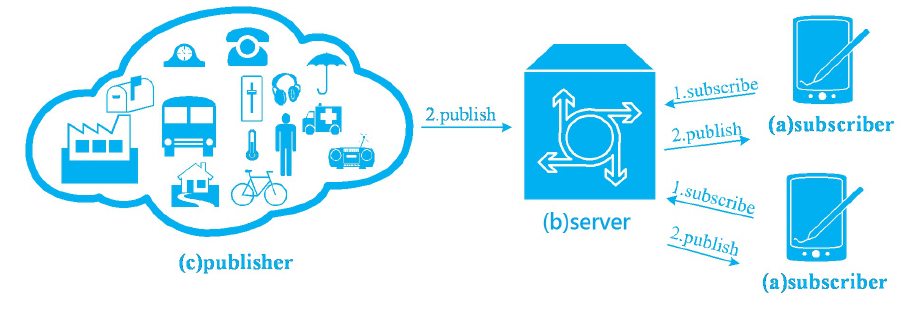
Figure 1. Publish/subscribe